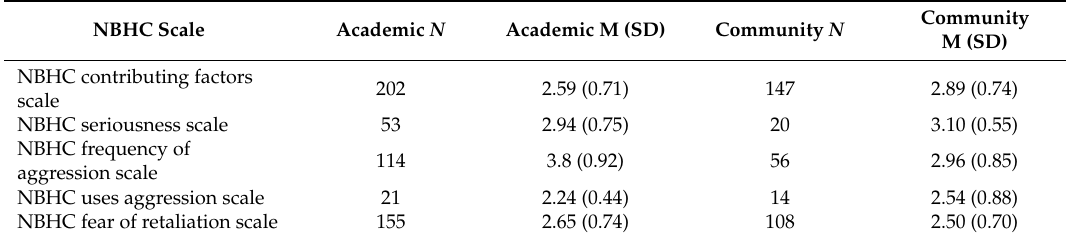
Table 4. Means (standard deviation) of composite scores from the negative behaviors in healthcare survey (NBHC) by hospital